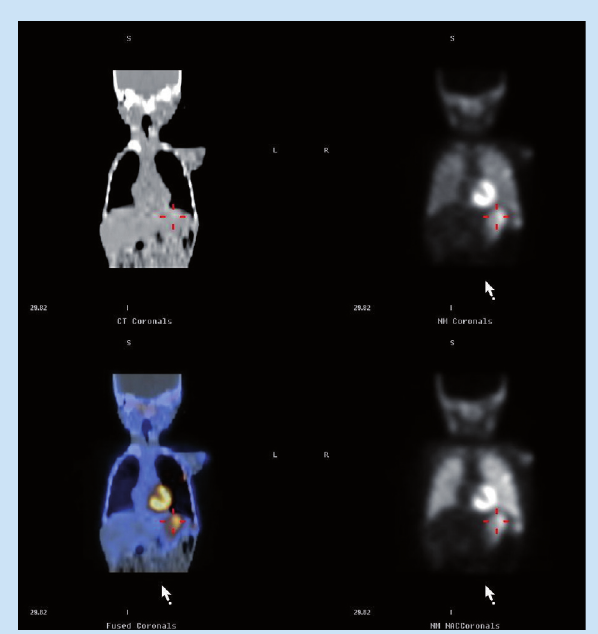
Fig. 3b. Tc-99m MDP SPECT-CT clearly localising the metastatic calcification in the lungs, myocardium and